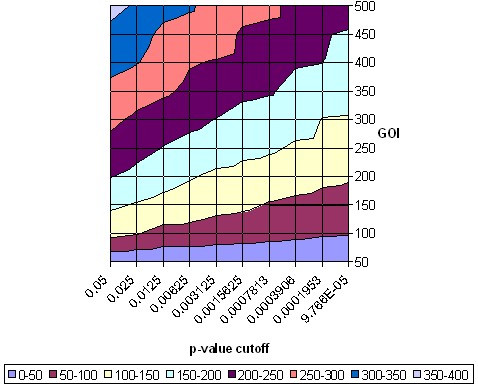
Overhead view of surface topology for the portion of the Wormbase data set. Different colors represent different numbers of significant terms.